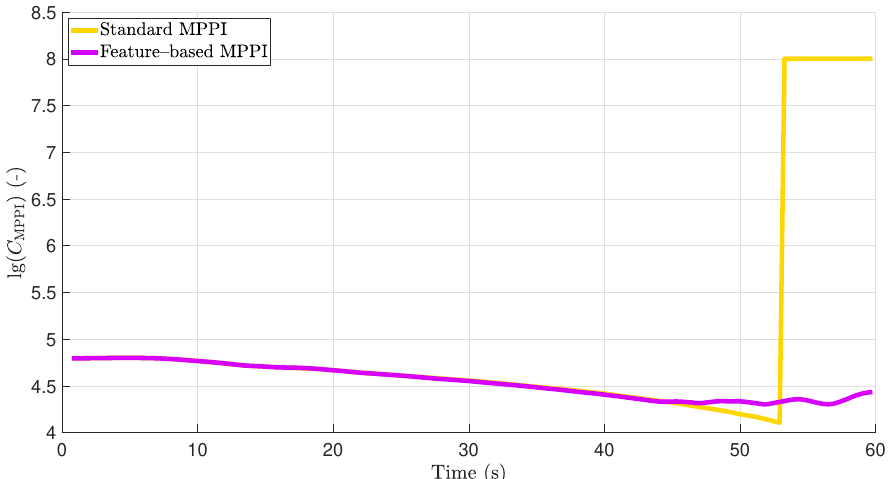
Figure 8. Comparison of costs in the simulation scenarios plotted over time. Note the logarithmic representation of the plotted